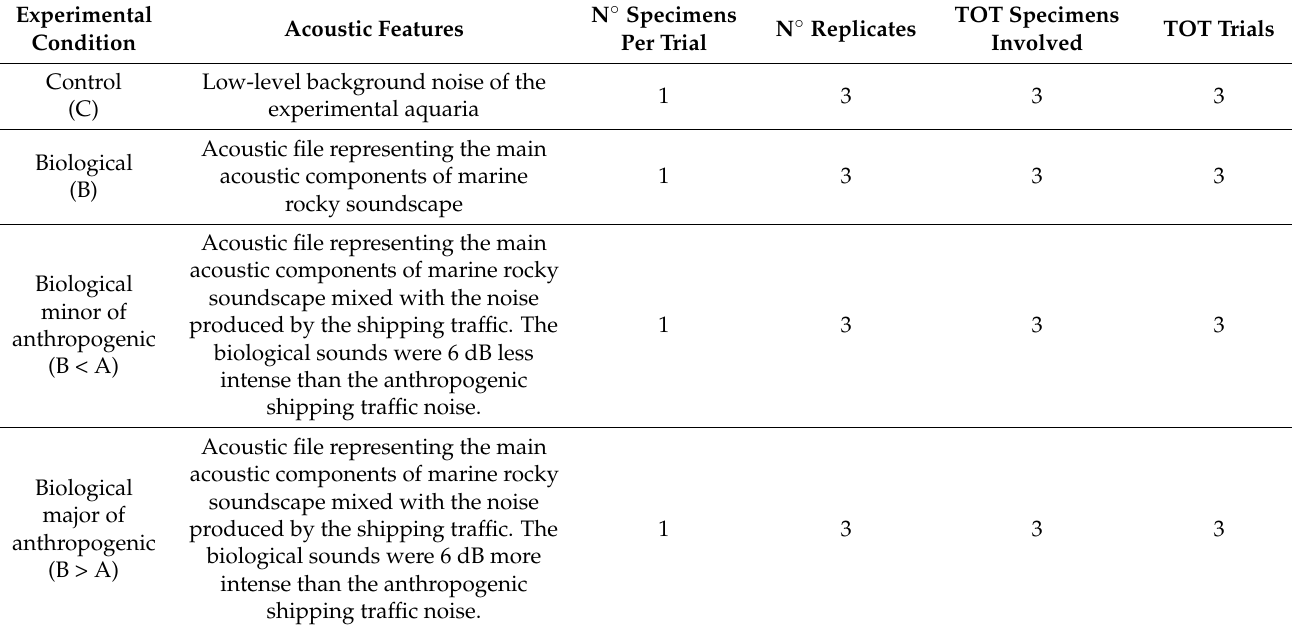
Table 1. Schematic view of the experimental condition